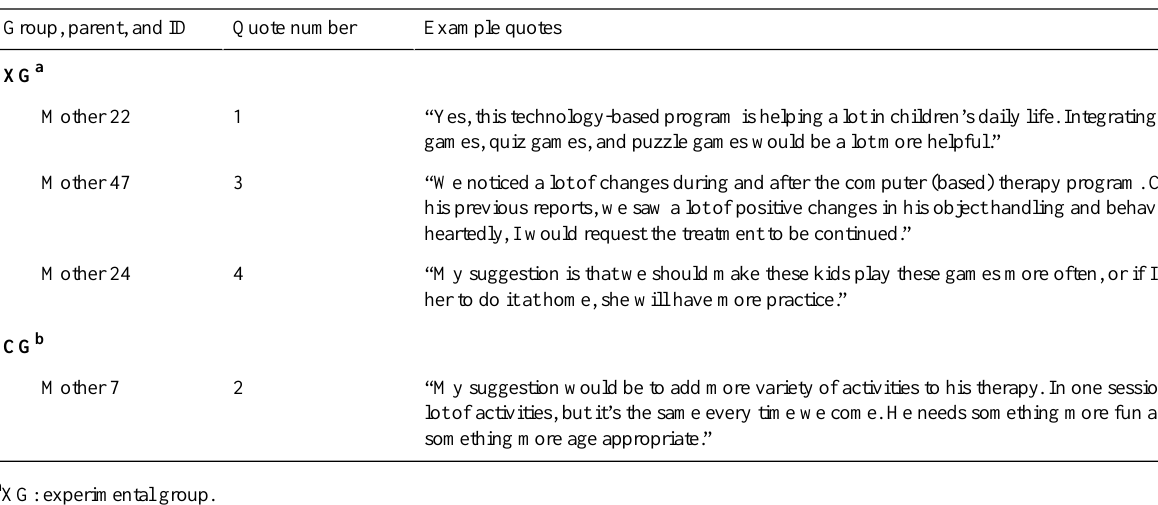
Table 7. Parents’suggestions to improve the